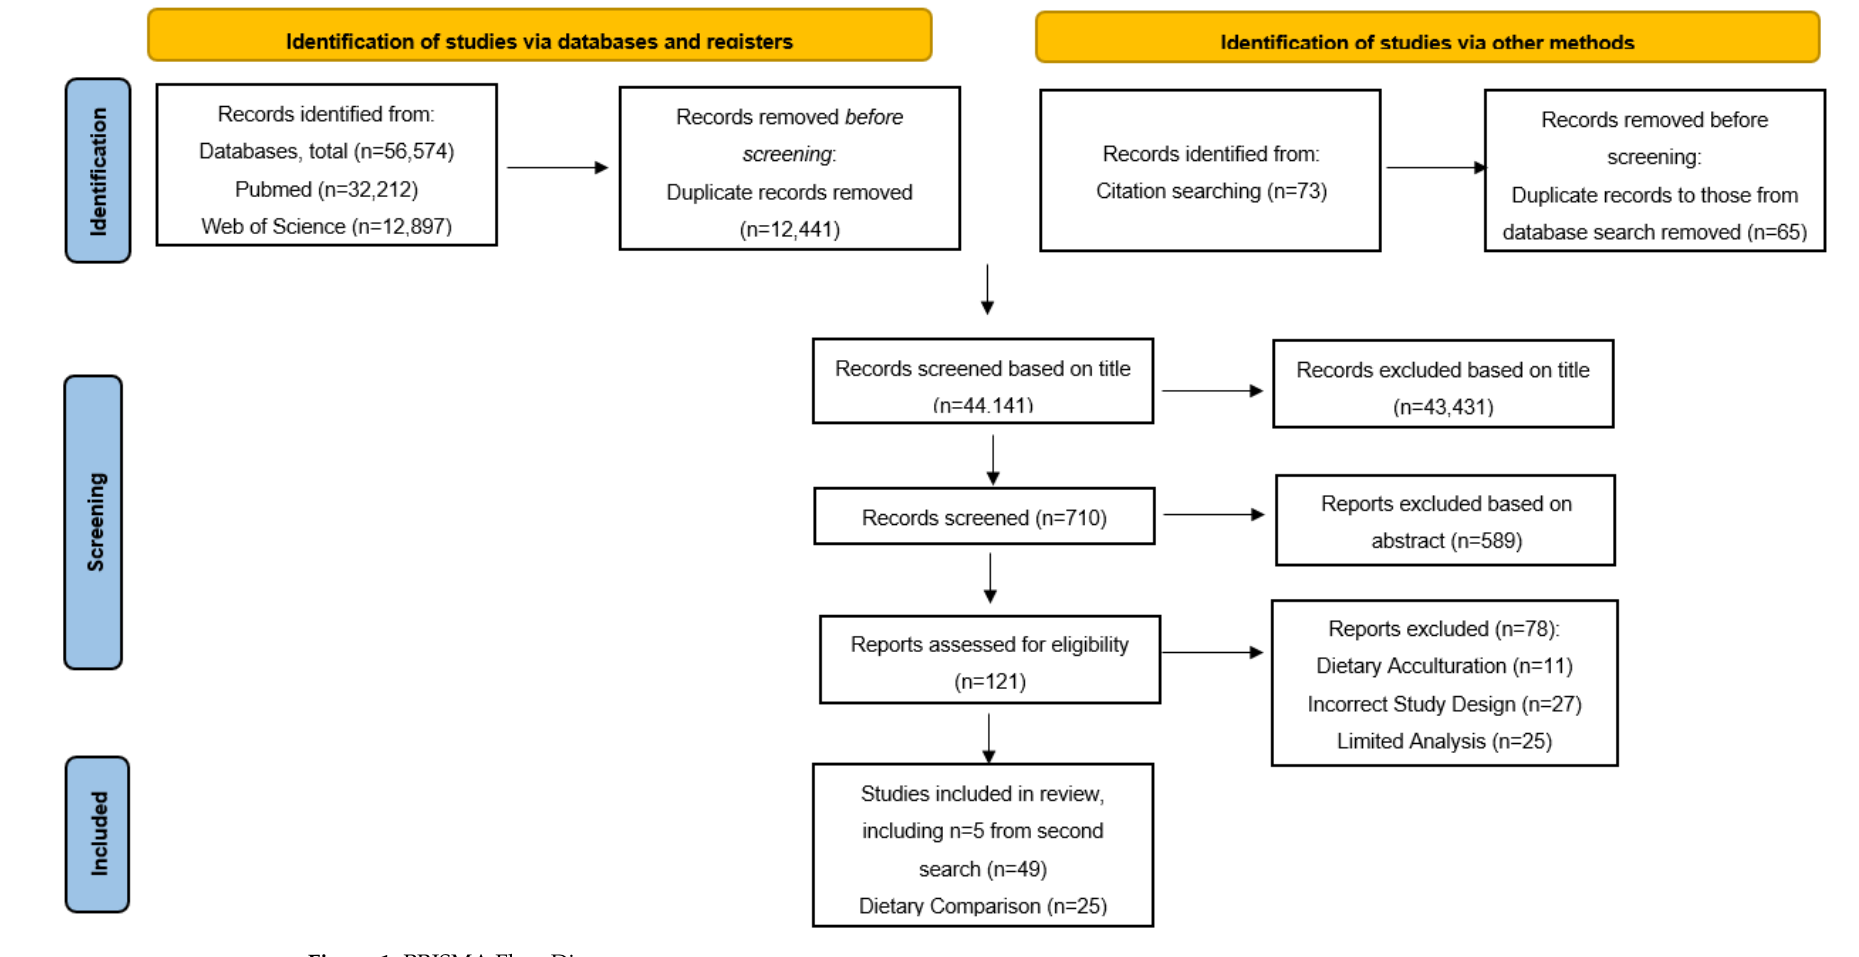
Figure 1. PRISMA Flow Diagram.